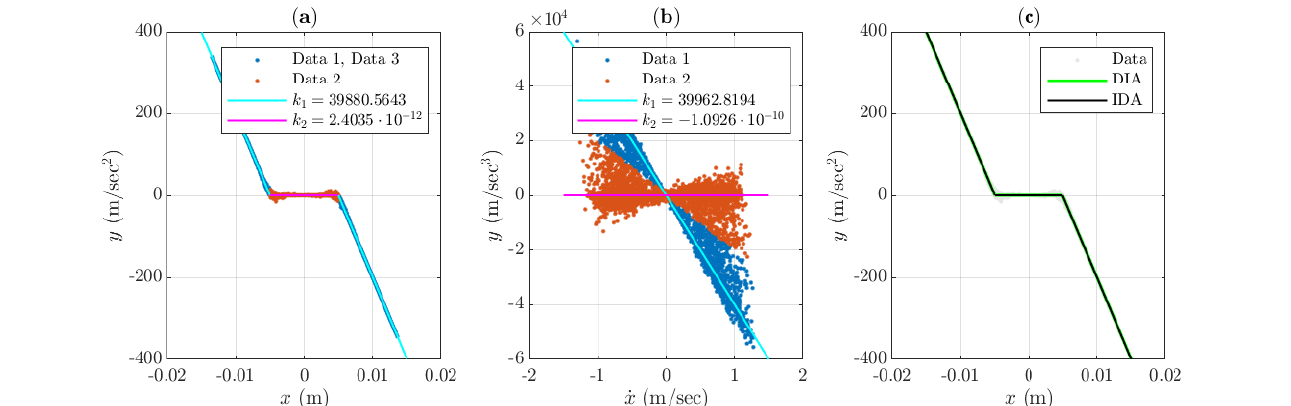
Figure 5. Results of the Lin-Ewin system identification with DIA and IDA: ( a ) data are divided into three subsets Data 1, Data 2, and Data 3 containing x i corresponding to µ i ( x i ) = 1. The subsets Data 1 and Data 3 are colored blue; Data 2 is colored red; ( b ) data are divided into two subsets Data 1 corresponding to µ 1 ( x i ) = 1 or µ 3 ( x i ) = 1, and Data 2 corresponding to µ 2 ( x i ) = 1. Both results are shown in the panel ( c ) and look rather similar, while the accuracy of finding k 1 is slightly better in case of IDA, and k 2 in both cases is very close to zero.